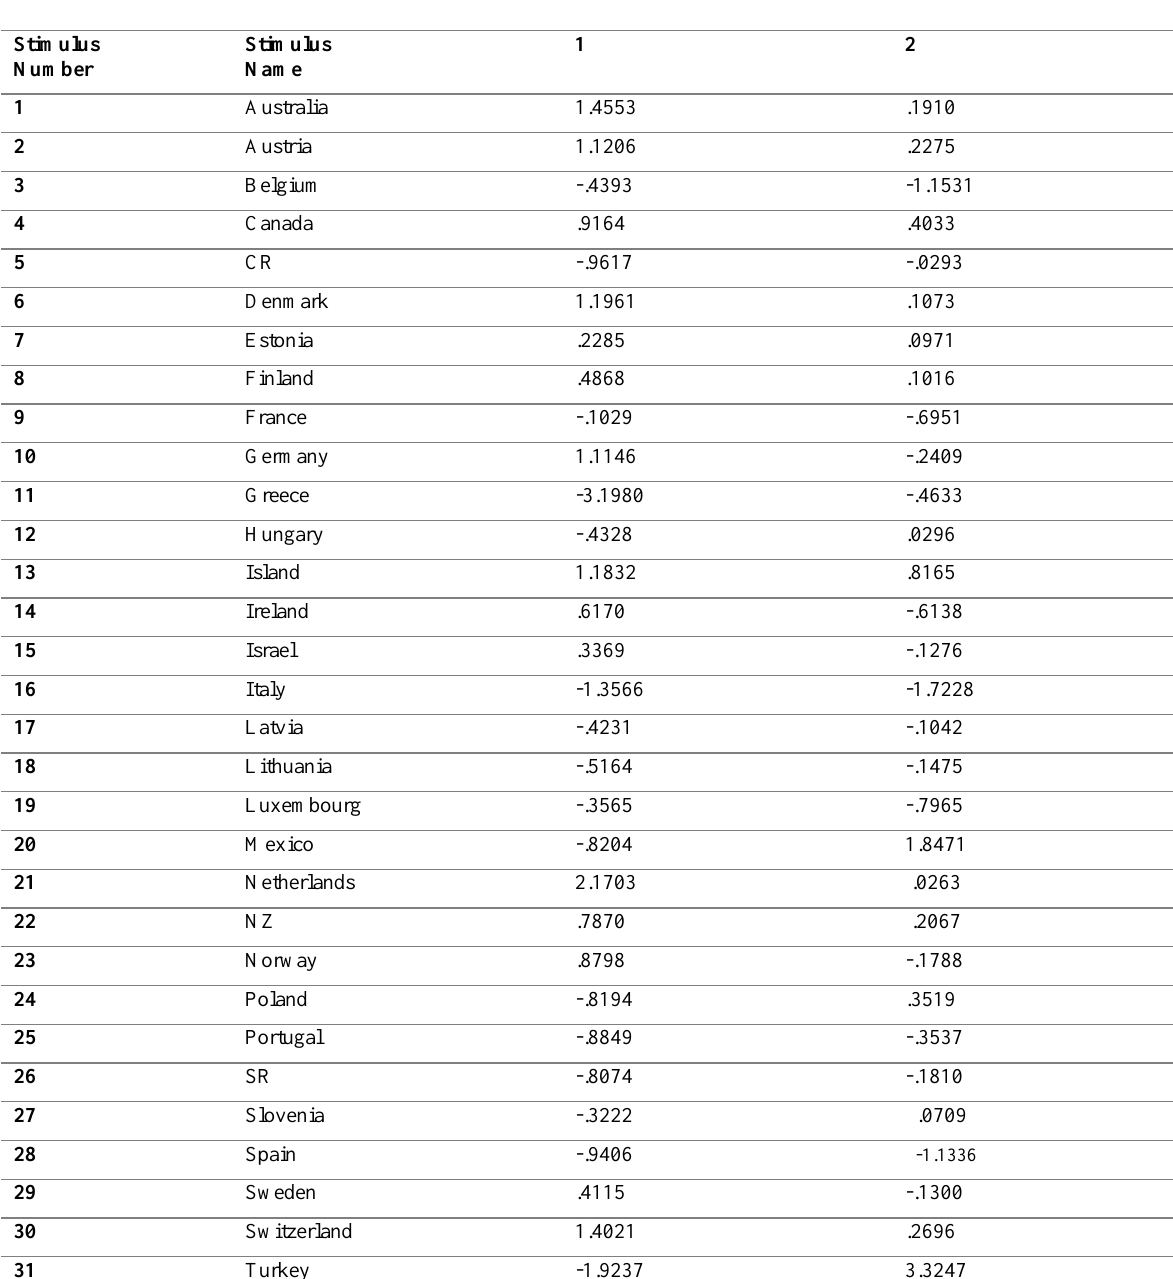
Table 5: Stimulus Coordinates